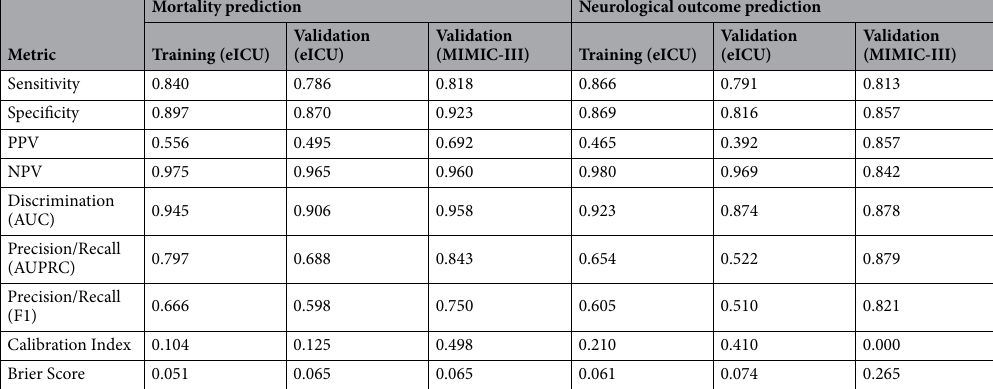
Table 2. Model performance metrics. eICU Training refers to the mean measurements across 20 randomly sampled subsets of the eICU data. eICU Validation refers to the mean measurements for the validation subsets corresponding to the 20 train samples. MIMIC Validation refers to the measurements collected by evaluating models trained on all of the eICU data on the MIMIC-III database. The model was evaluated with a positive prediction referring to unfavorable outcome (death labeled as 1, discharge mGCS ¡6 labeled as 1). The relatively low PPV for the two eICU datasets (training and validation) in the model partially result from a high class imbalance resulting in few positive examples (216, or 12.8% for mortality, 170, or 11.5% for neurological outcome). The MIMIC data had markedly lower class imbalance, leading to a higher PPV. NPV negative predictive value, PPV positive predictive value; AUC area under the receiver operating characteristic curve, AUPRC area under the precision recall curve, F1 F1 score or the harmonic mean of precision and recall, eICU eICU Clinical Research Database, MIMIC Medical Information Mart for Intensive Care-III database.